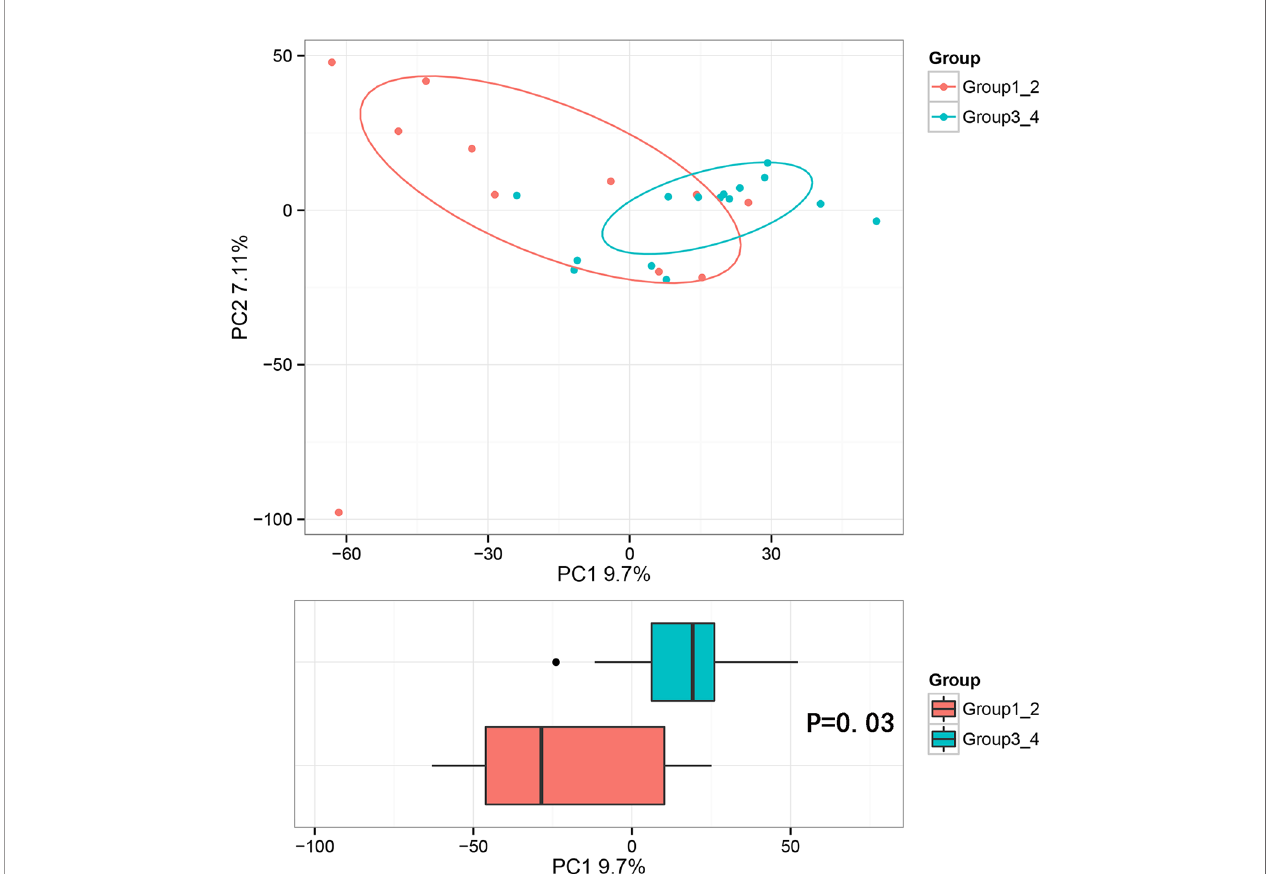
FIGURE 3 | Principal component analysis (PCA) based on OTU abundance between healthy men and BCa patients (Adonis test, Bray – Curtis). x-axis, 1st principal component and Y-axis, 2nd principal component; 9.7% in brackets represents contributions of PC1 components to samples, 7.11% represents contributions of PC2 components to samples. A dot represents each sample, and different colors represent different groups (red: healthy men and blue: BCa patients).